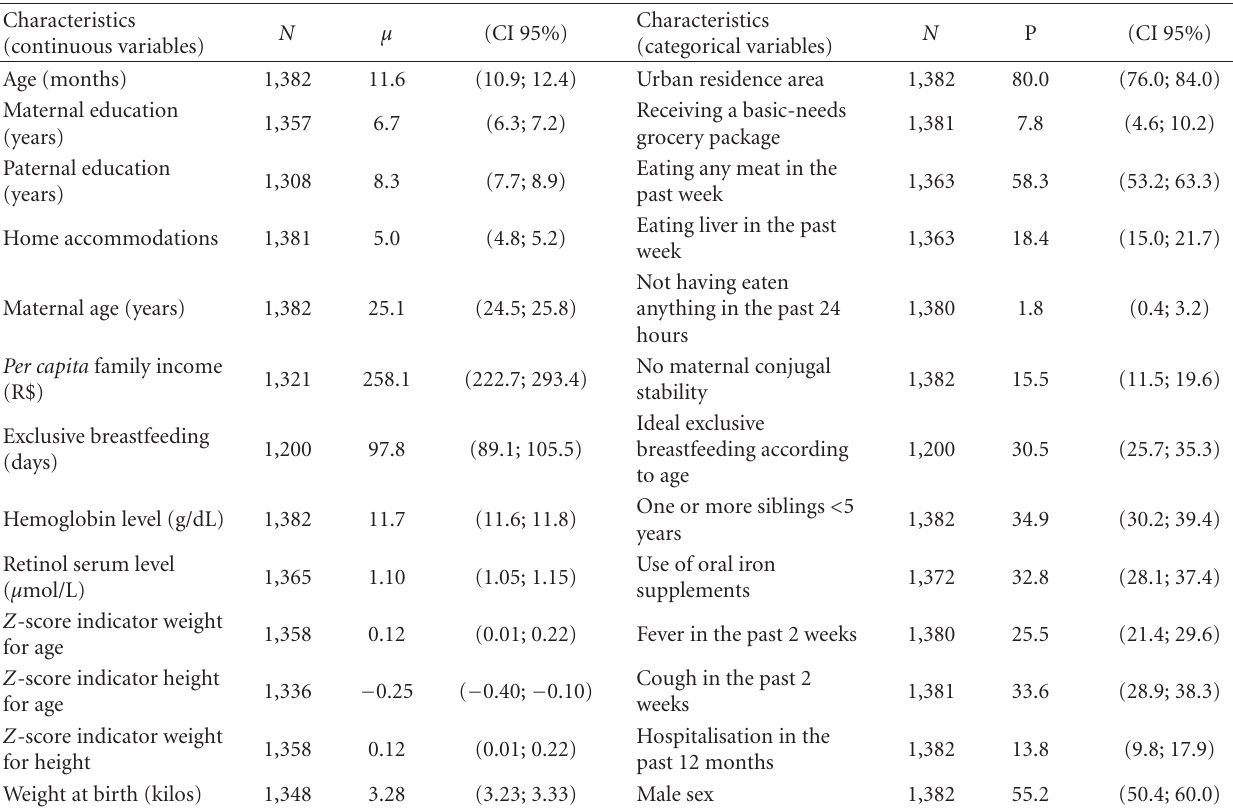
Table 1: Averages and prevalence of the characteristics of children younger than 24 months old who participated in the Brazilian National Survey on Demography and the Health of Women and Children (PNDS 2006), with their respective confidence intervals (CI